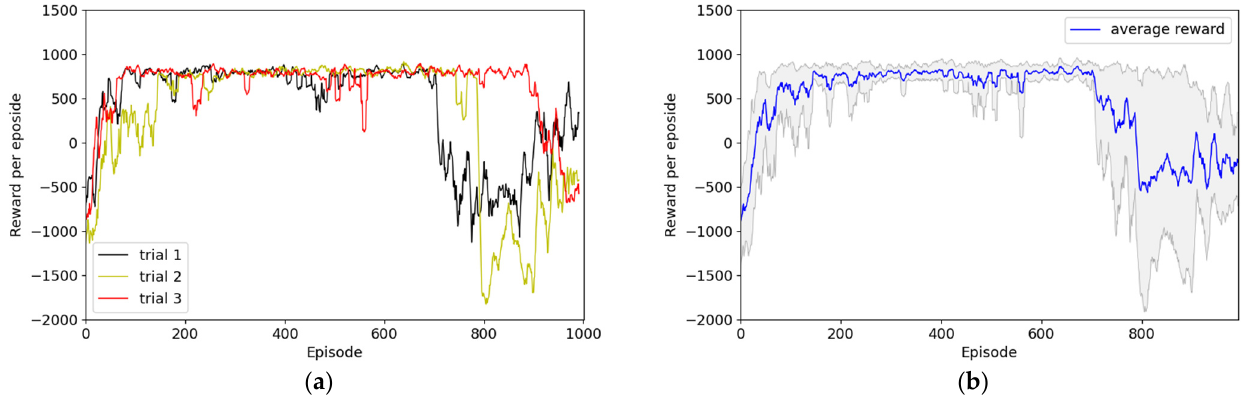
Figure 11. Results of Experiment 2: reward system applied with sufficient reward engineering with HER. ( a ) Episode rewards for each of the three trials; ( b ) maximum, minimum, and average values of episode rewards considering all three episodes.